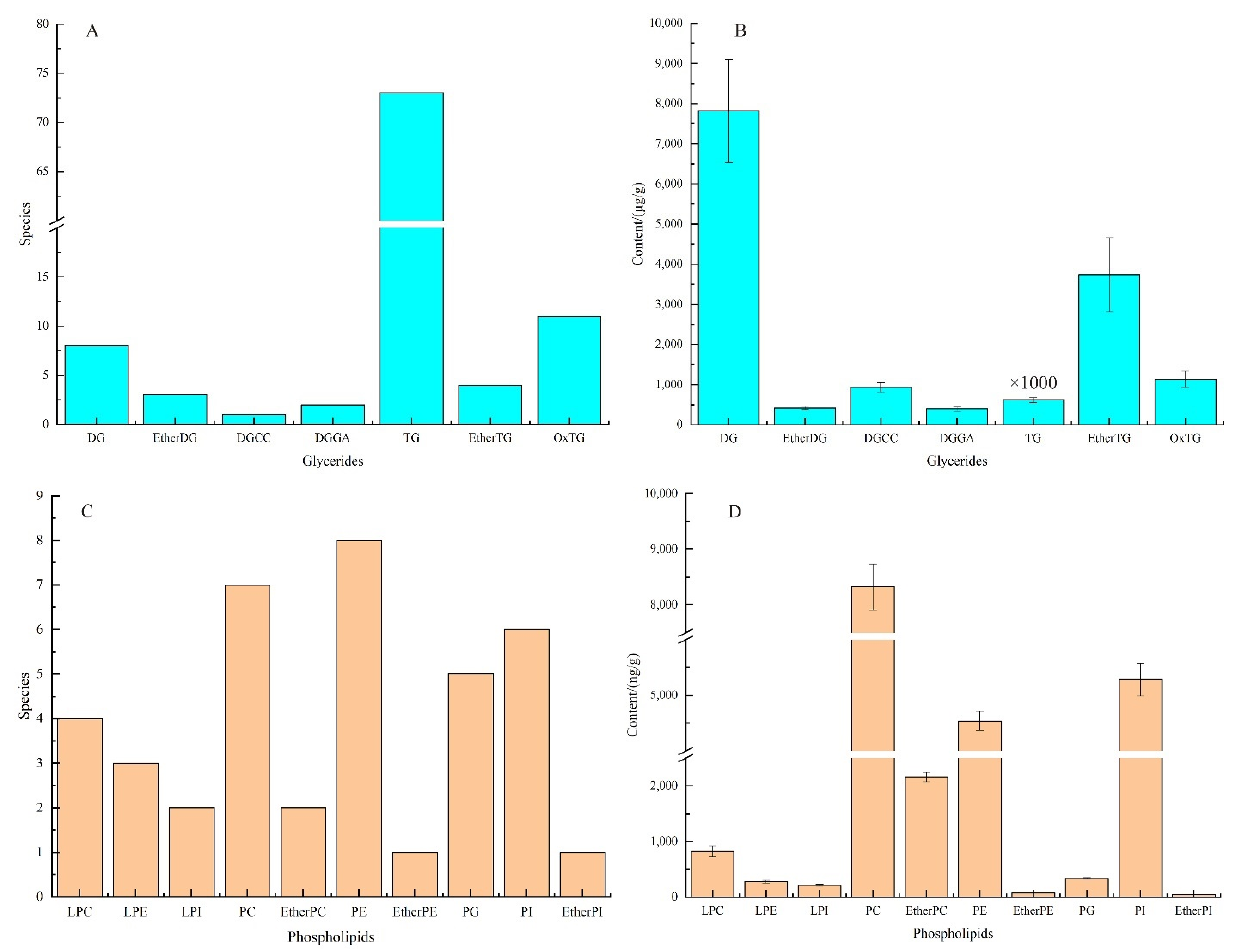
Figure 1. ( A , B ) represents the number and content of different phospholipids, ( C , D ) represents the number and content of different glycerides, respectively.